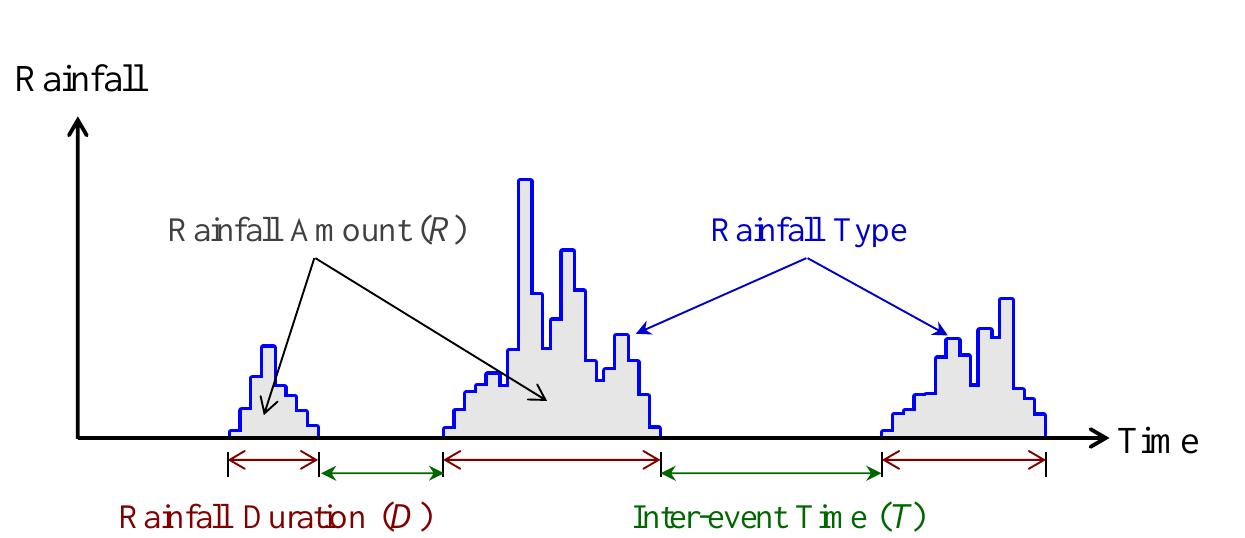
Figure 1. Example of rainfall time series and parameters.